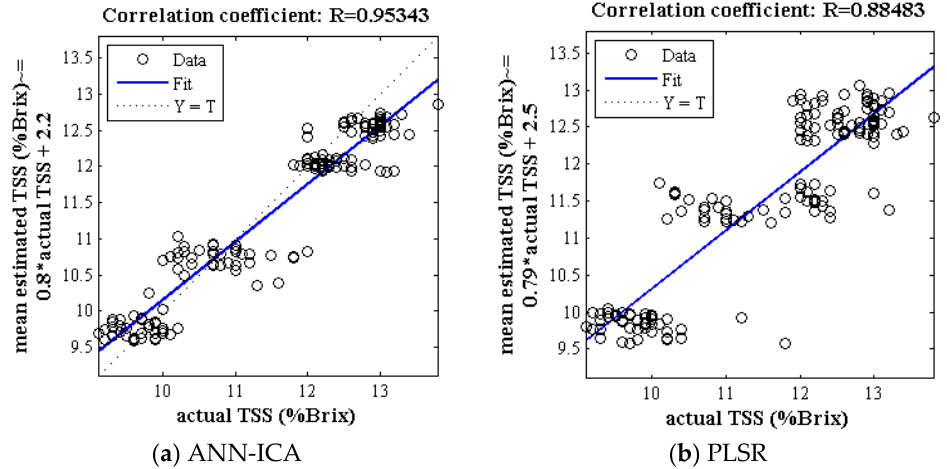
Figure 2. The correlation plot between mean predicted and true value of TSS of Gala cultivar (test set) for methods of ANN-ICA and PLSR. The multiply operation is denoted by the symbol *.